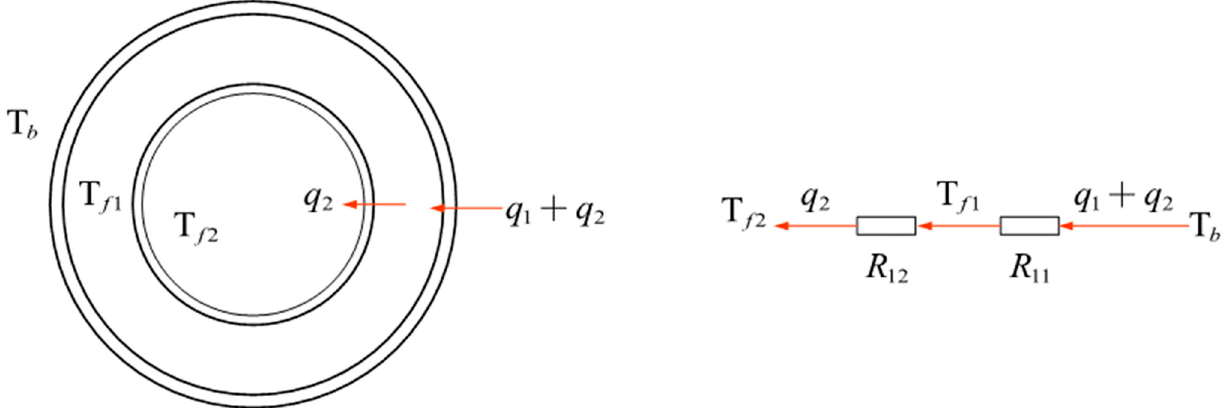
Figure 5. Schematic for cross section of coaxial annular borehole heat exchanger and corresponding thermal circuit.